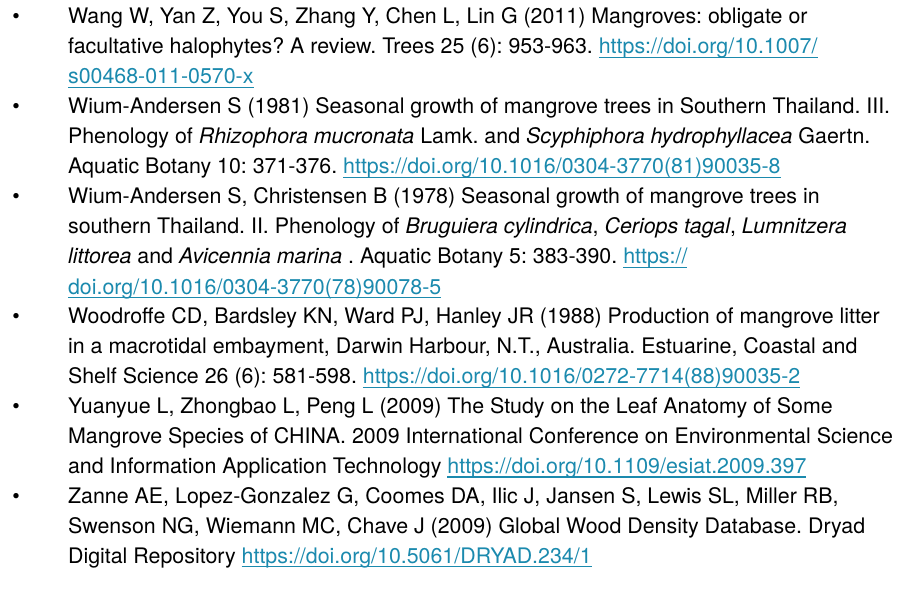
Suppl. material 1: Matrix of traits per species showing the number of records per each